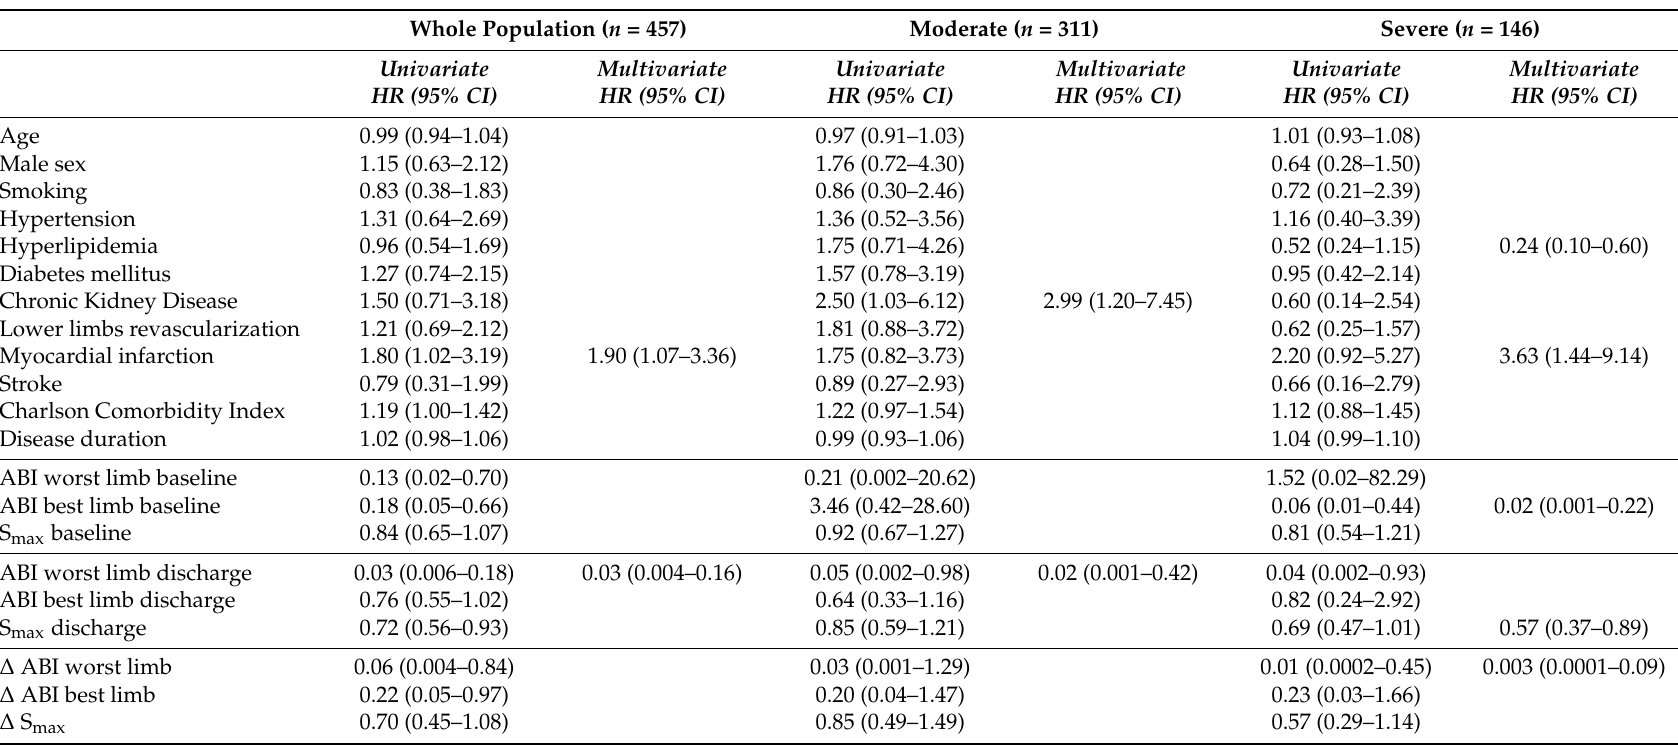
Table 3. Results of Cox proportional hazards regression analyzing the capability of the study variables for the prediction of 3-year revascularization in the whole population and in the two patient